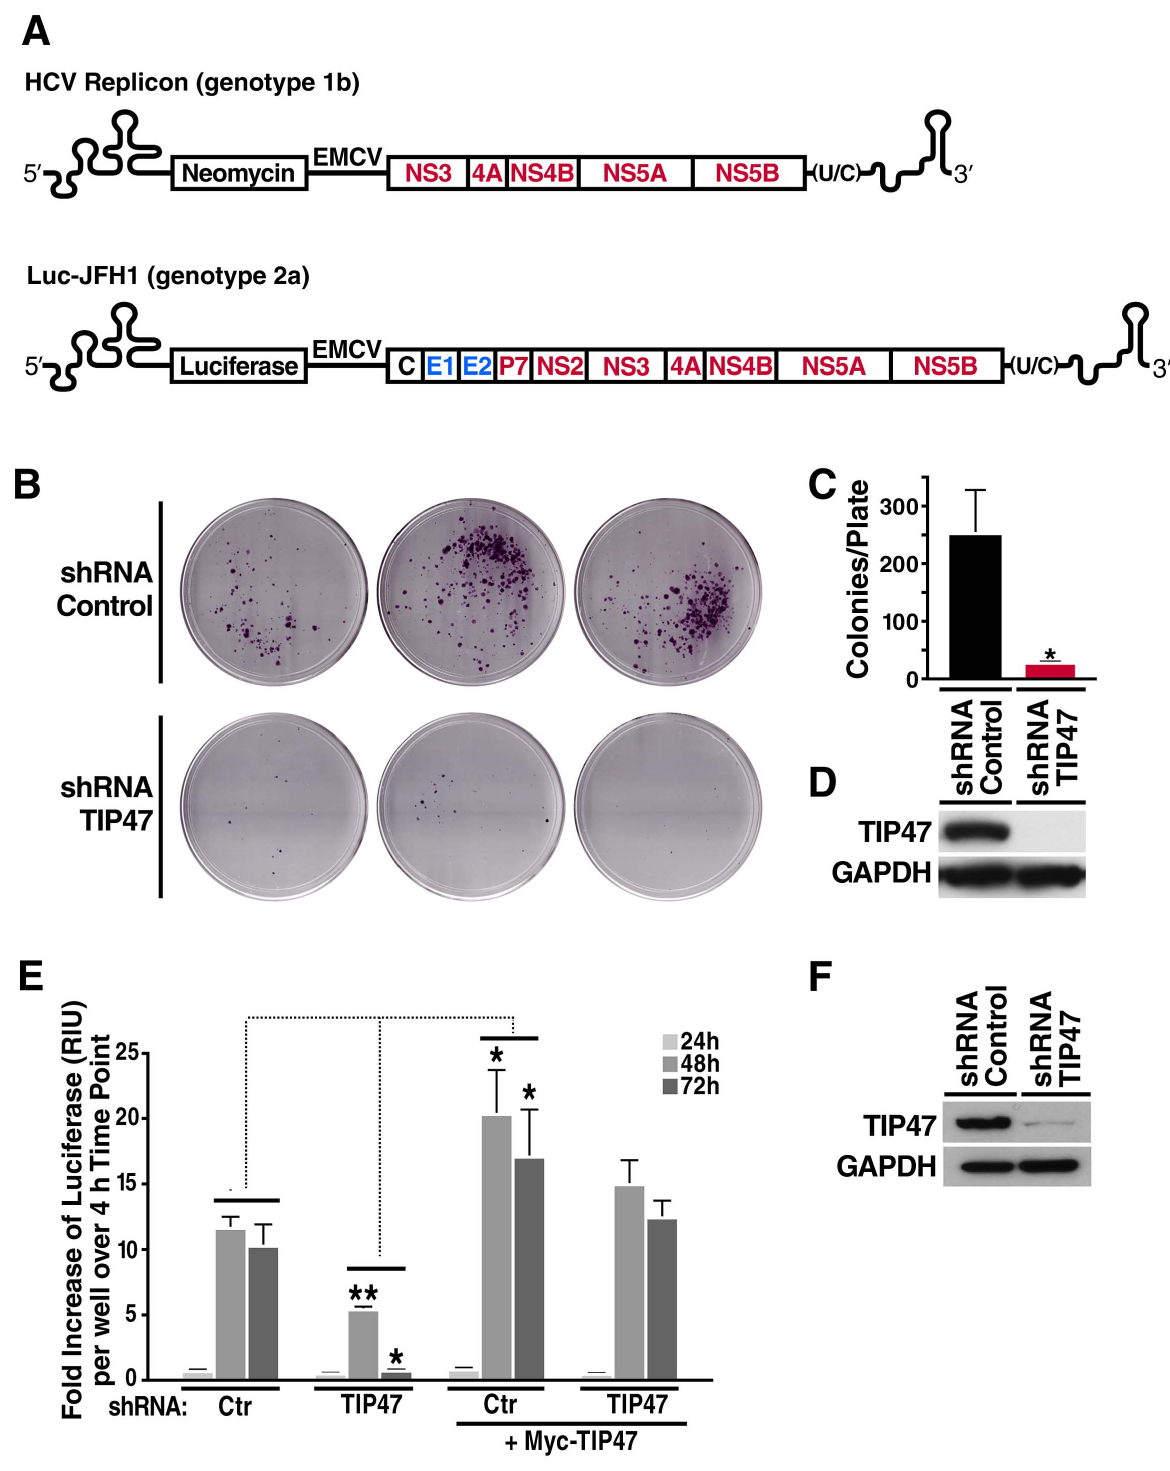
Figure 2. TIP47 is required for HCV RNA replication. A) Schematic representation of HCV Replicon (Con1, genotype 1b), a subgenomic bicistronic HCV replicon with neomycin as a reporter gene, and Luc-JFH1 (genotype 2a), a full-length bicistronic HCV infectious clone with firefly luciferase as a reporter gene. B) Crystal violet-stained Huh7.5 cells transfected with control shRNA or shRNA against TIP47 and HCV replicon RNA (A). G418 was added to the medium (1 mg/ml). Cells were kept under selective pressure for 4 weeks. Only cells actively replicating HCV RNA, and thus expressing the neomycin phosphotransferase survive. C) Quantification of colony numbers/plate in (B) (mean 6 standard deviation; n=3, *P , 0.05). D) Western blot analysis of TIP47 expression in shRNA-expressing Huh7.5 cells at the time of transfection in (B). E) Transfection of shRNA-expressing Huh7.5 cells with Luc-JFH1 RNA (A) and Myc-TIP47 expression plasmid (where indicated). HCV replication was measured by determining the fold increase of luciferase (RLU) per well over a 4 h time point (mean 6 standard deviation; n=3; *P , 0.05, **P , 0.01). F) Western blot analysis of TIP47 expression in shRNA-expressing Huh7.5 cells at time of transfection in (E). doi:10.1371/journal.ppat.1003302.g002 PLOS Pathogens |